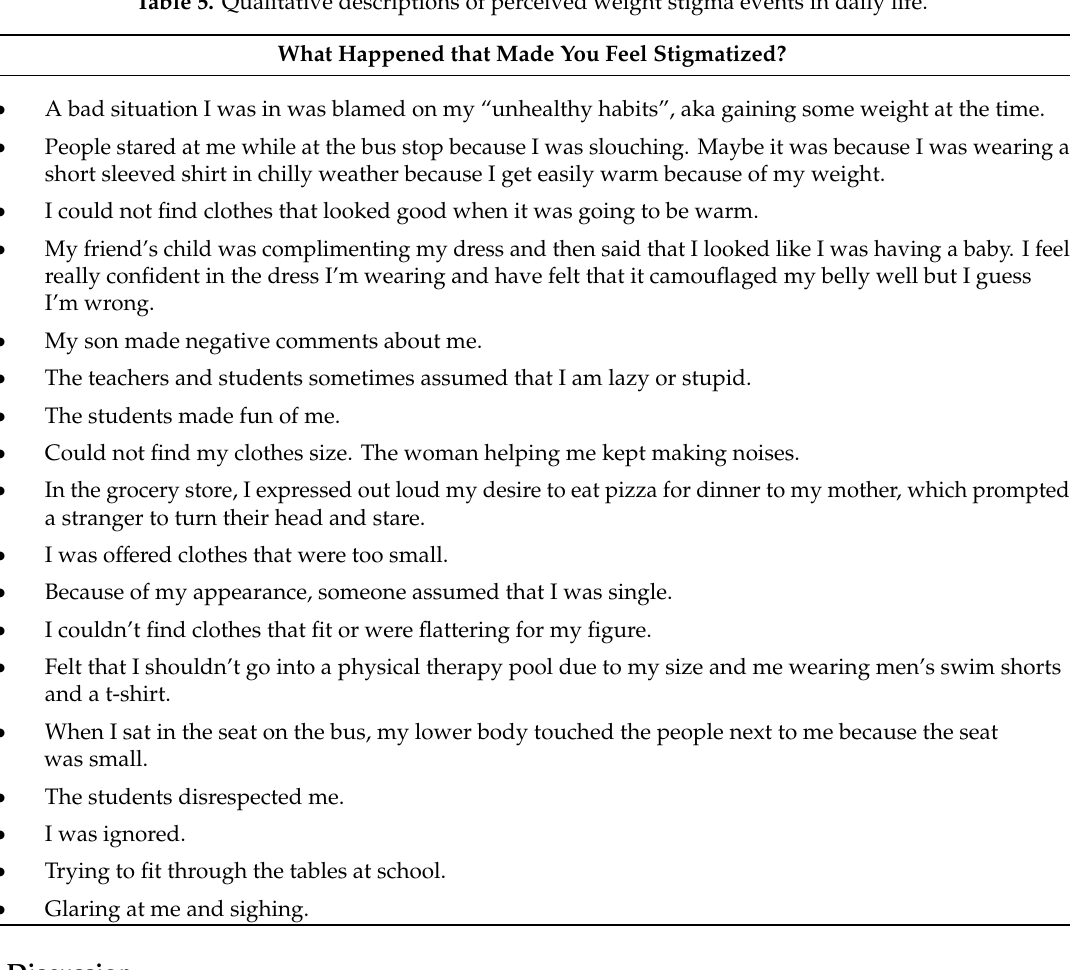
Table 5. Qualitative descriptions of perceived weight stigma events in daily